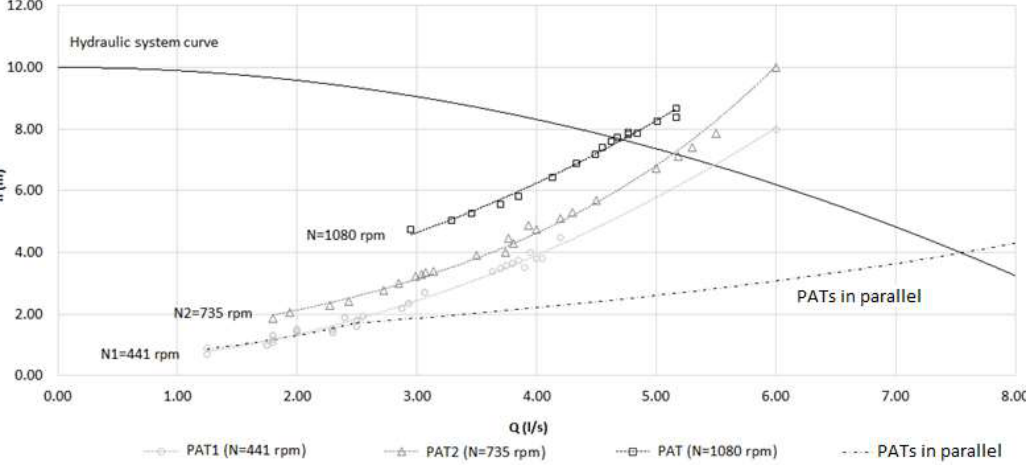
Figure 17. Operation of PATs working in parallel (PAT1, PAT2, and PATs) and in single mode (PAT).